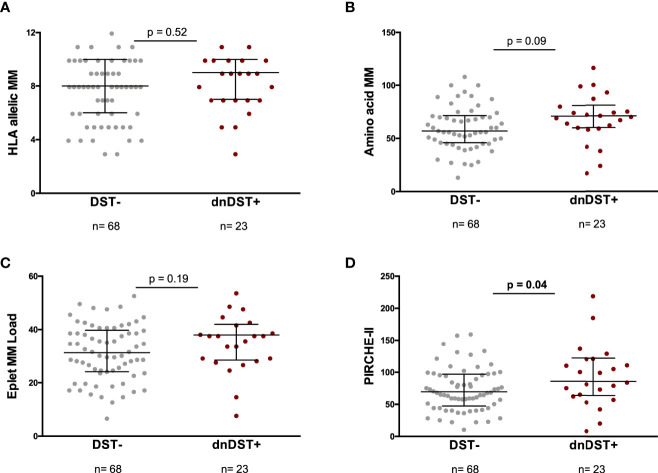
HLA allelic MM, amino acid MM, eplet MM load, global PIRCHE-II and de novo DST. Comparisons between HLA MM scores and dnDST- or dnDST+ patients. (A) HLA allelic MM 7.66 ± 2.3 vs 8.05 ± 2.2, p=0.52. (B) Amino acid MM 60.52 ± 20.6 vs 69.47 ± 25.8, p=0.09. (C) eplet MM load 31.62 ± 10.5 vs 35 ± 10.5, p=0.19. (D) PIRCHE-II 74.1 ± 33.2 vs 94.8 ± 48.1, p=0.04. MM, Mismatch; DST, donor specific.